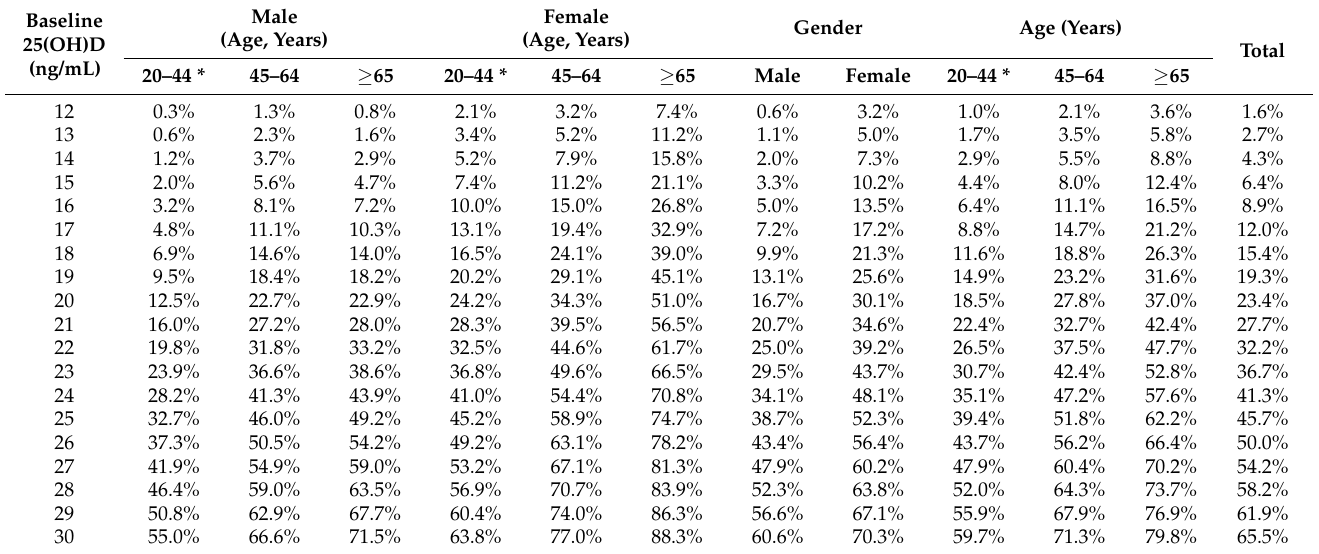
Table 4. Percentage of healthy individuals (percentile) with 25(OH)D levels below the values in the first